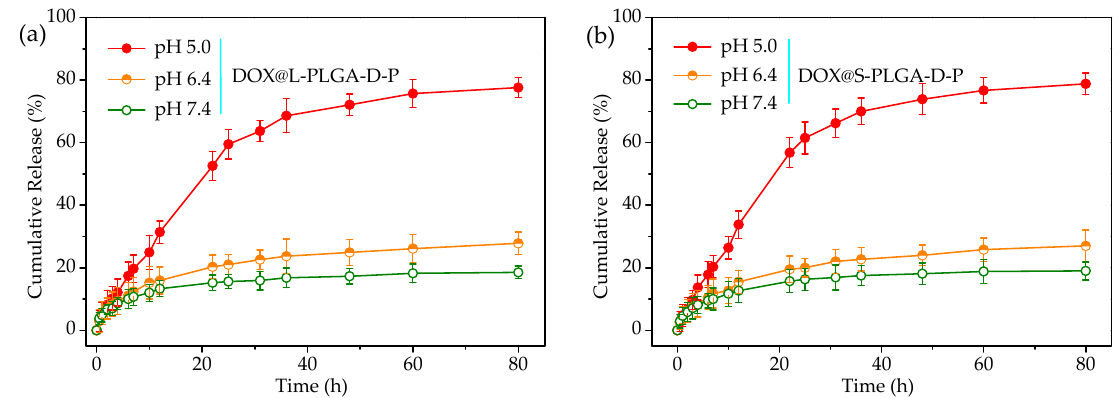
Figure 6. In vitro drug release curves of DOX@L-PLGA-D-P ( a ) and DOX@S-PLGA-D-P ( b ) under different pH conditions (pH 7.4, 6.4 and 5.0).